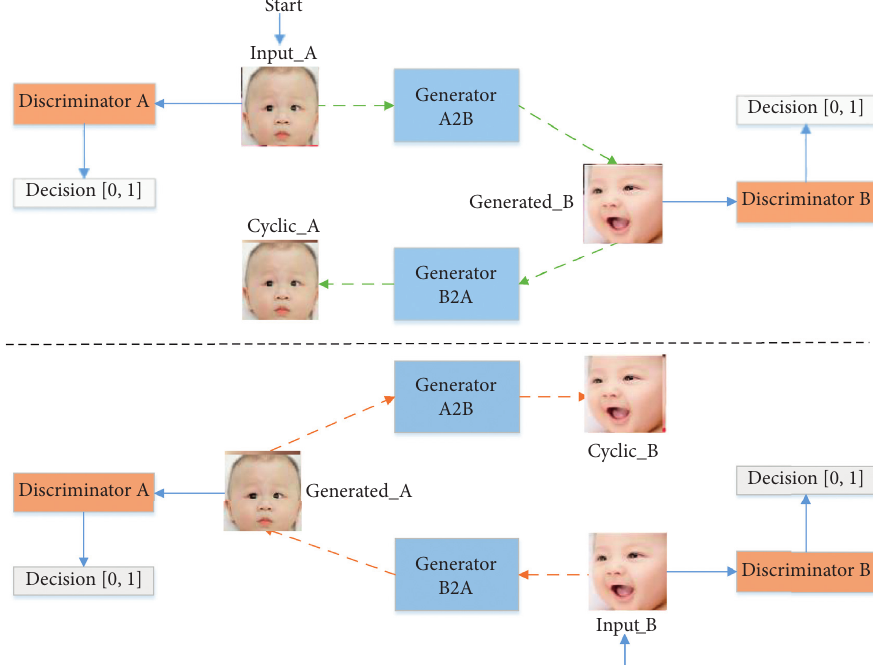
Figure 2: Example of happy expression image data augmentation process. Table 2: Expression details for the BabyExp dataset.